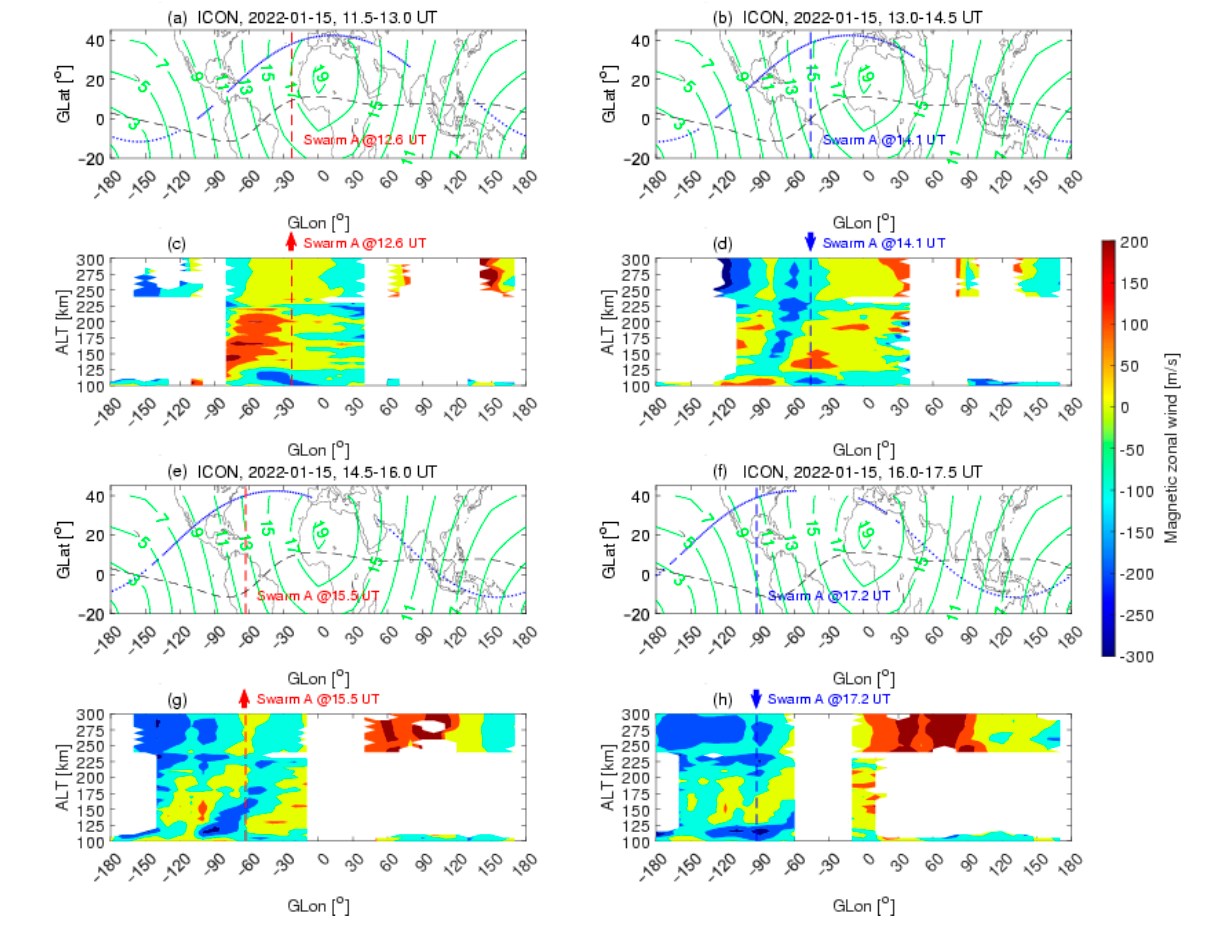
Figure 3. Panels ( a , b , e , f ): The ICON orbit track segment is displayed as a blue curve as a function of the geographic latitude and longitude. The iso-distance lines surrounding the Tonga volcano eruption epicenter are marked at 2000-km intervals in green. The black dashed curves mark the magnetic equator. The red vertical dashed line shows the longitude of the upward FRC observed by the Swarm constellation, while the blue vertical dashed line shows the longitude of the downward FRC observed by the Swarm satellites in the daytime. Panels ( c , d , g , h ): The magnetic zonal wind is displayed as a function of the altitude and geographic longitude. The red arrows and vertical dashed lines denote the longitude of the radially upward FRC, while the blue arrows and vertical dashed lines denote the radially downward FRC.